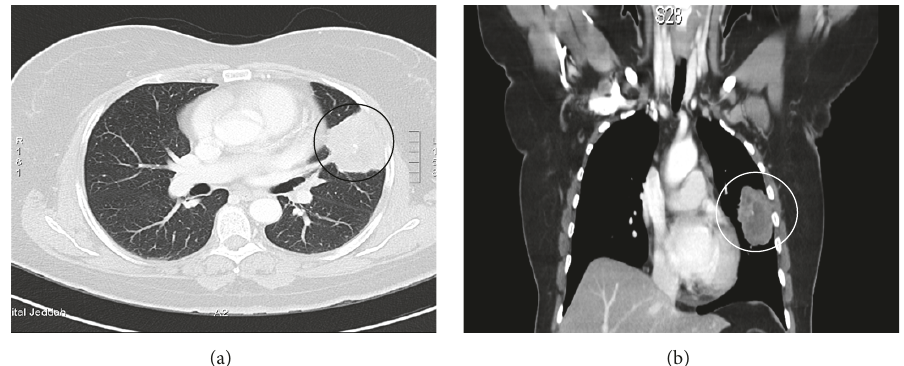
Figure 2: (a) Axial and (b) coronal contrast-enhanced chest CT scan showing malignant looking pleural-based lobulated left upper lobe soft